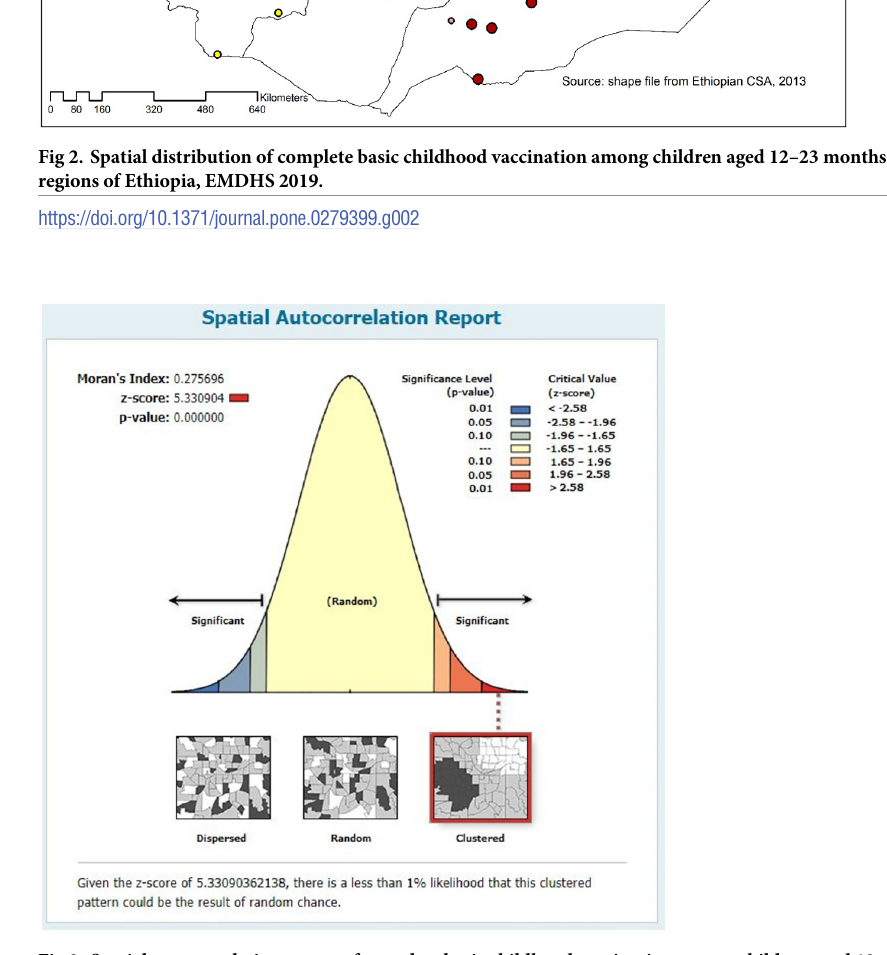
PLOS ONE | https://doi.org/10.1371/journal.pone.0279399 January 6, 2023 8 /